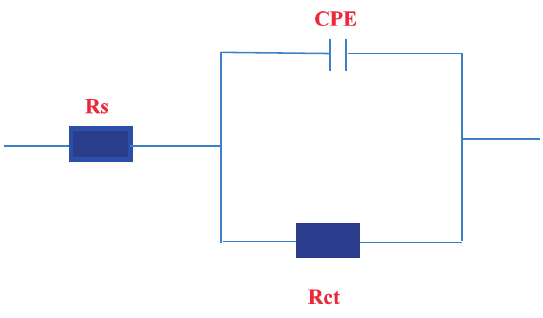
Figure 8. Equivalent circuit used for fitting the impedance data in 1 M HCl